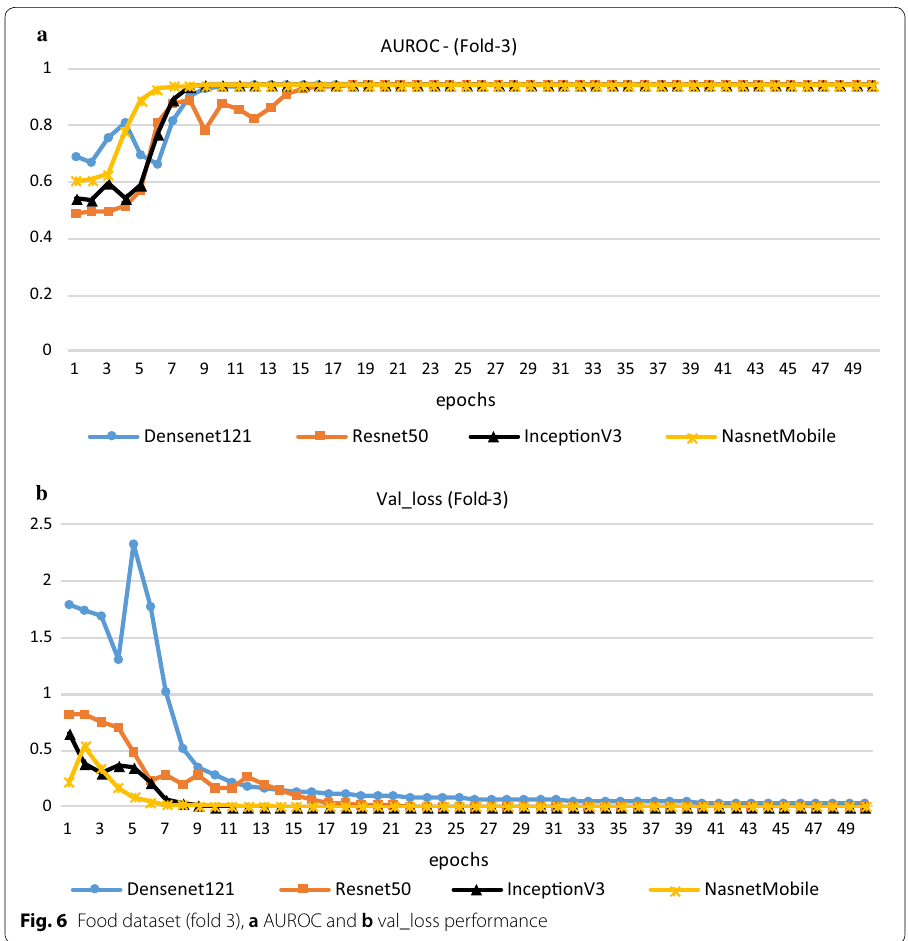
Fig. 6 Food dataset (fold 3), a AUROC and b val_loss